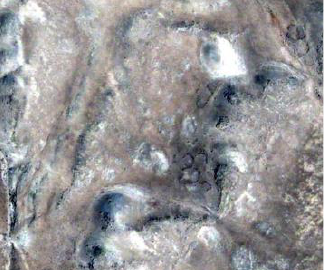
Figure 15. QuickBird image revealing corrals and cairns/ tumuli on Jebel Bishri. © EurImage.